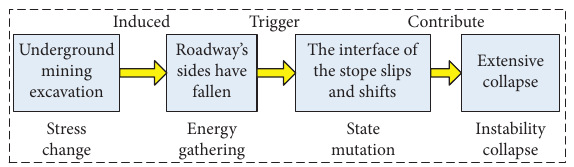
Figure 3: Catastrophe of the mining collapse chain.